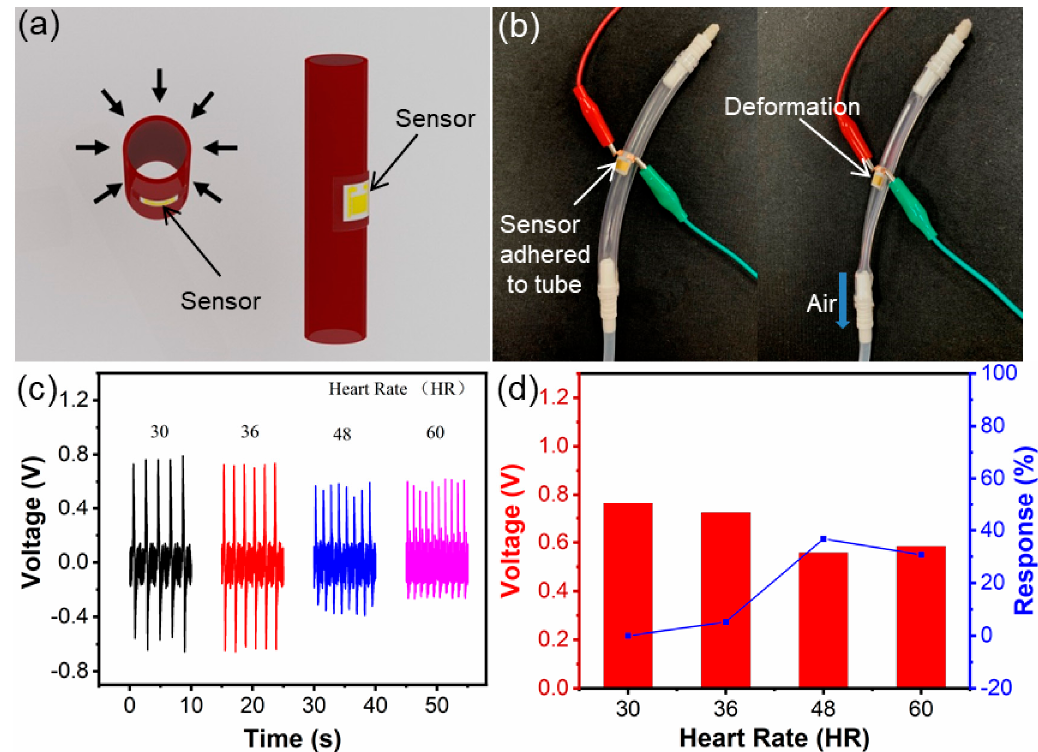
Figure 4. Photo of simulated arterial biosensor and characterization of output piezoelectric voltage. ( a ) Simulation of arterial work and biosensor attachment position. ( b ) Arterial model. ( c ) Output piezoelectric voltage of the arterial model monitored by biosensor. ( d ) Output piezoelectric voltage response.